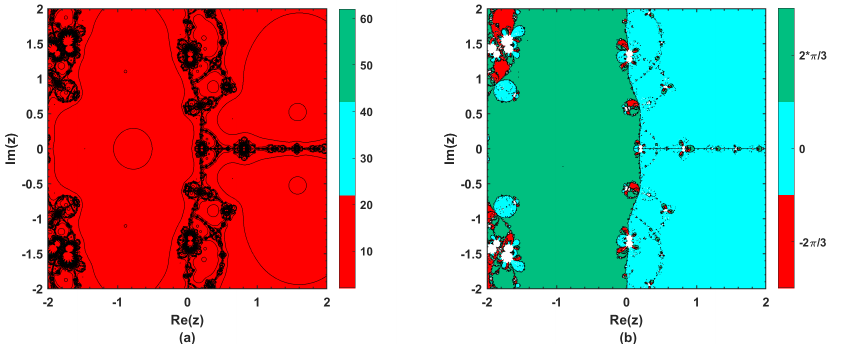
Figure 4. The polynomiographs obtained by the proposed method PS9 for P 4 ( z ) .